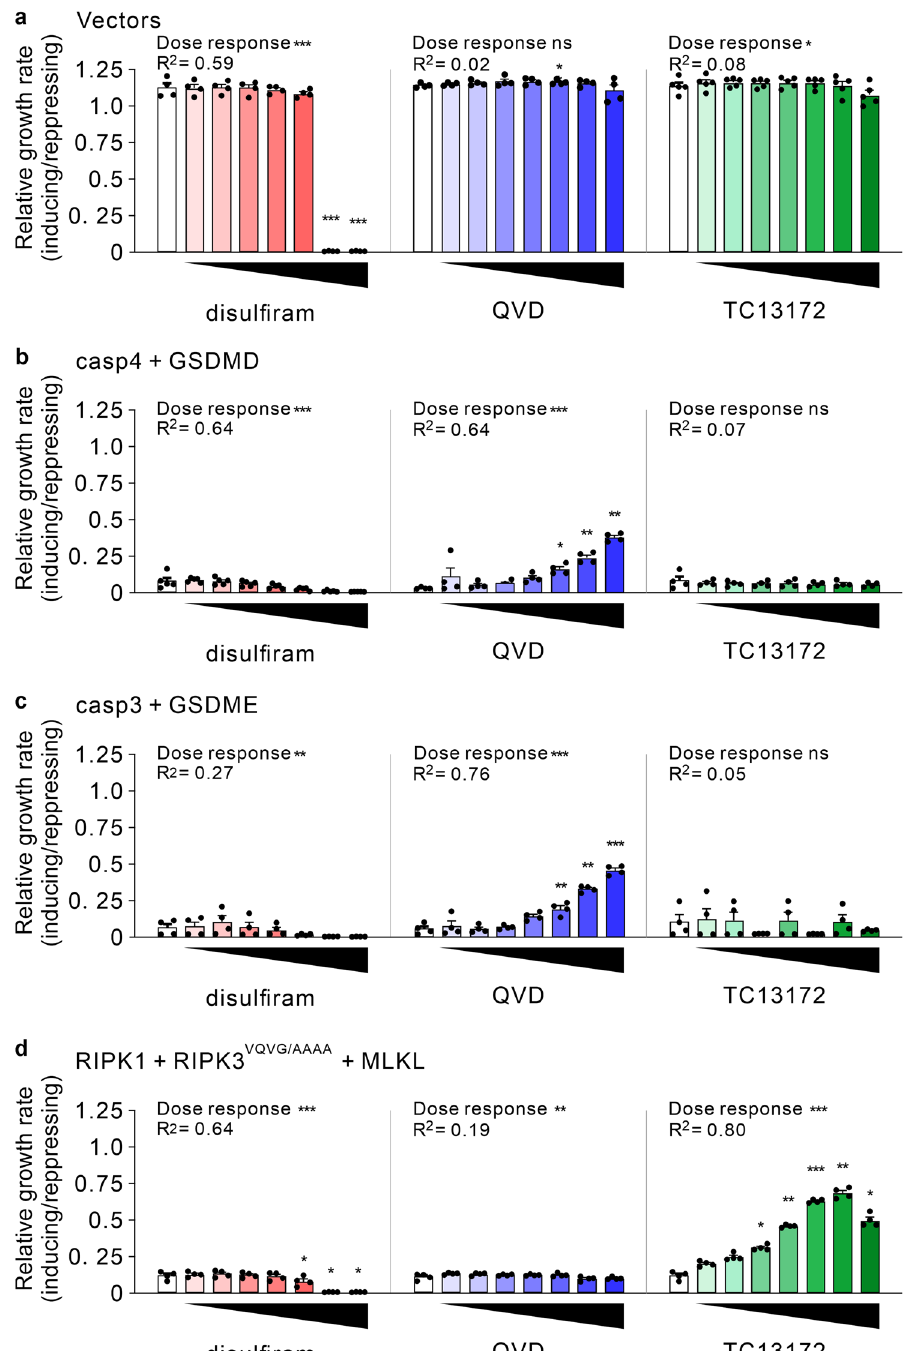
Figure 5. QVD enhanced the proliferation of yeast expressing caspases plus gasdermins, but tolerated concentrations of disulfiram did not. Yeast bearing empty vectors lacking cell death genes ( a ) or plasmids encoding caspase-4 plus GSDMD ( b ), caspase-3 plus GSDME ( c ) or RIPK1, a RHIM mutant of RIPK3 and MLKL (all human) ( d ) were grown in inducing or repressing liquid media containing 1% DMSO and either no drug (white columns) or 1, 2, 4, 8, 16, 32 or 64 µM of disulfiram, QVD or TC13172. The ratio of maximal growth rates in inducing versus repressing media were calculated. Data present mean ± SEM of 3–4 independent assays. Responses to each treatment were compared to untreated samples using one way ANOVAs with Sidak corrections. Statistically significant effects ( P < 0.05) are denoted by asterisks above the columns. A test for trend was performed to identify significant drug responses (either positive or negative). R 2 denotes the fraction of the total variance accounted for by the trend. *, P < 0.05; **, P < 0.01; ***, P <